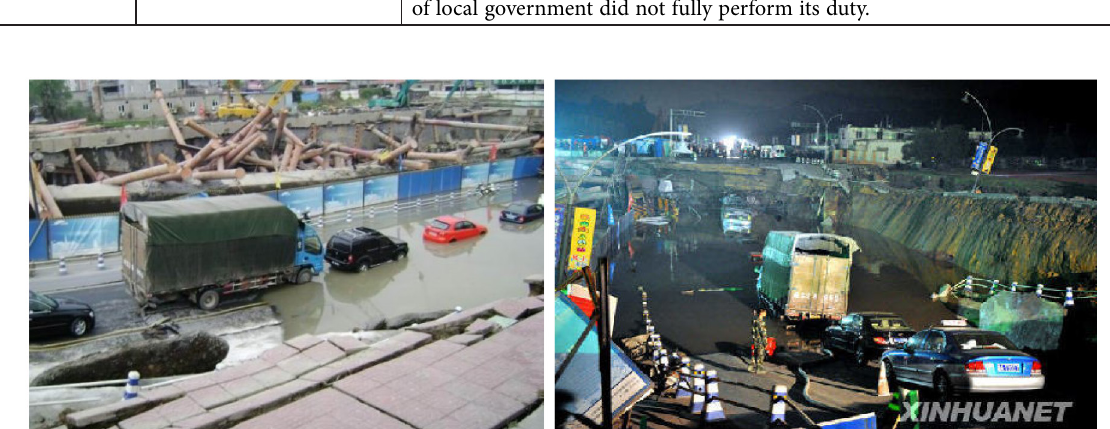
Figure 10. Onsite sceneries of Hangzhou underground railway tunnel collapse accident in